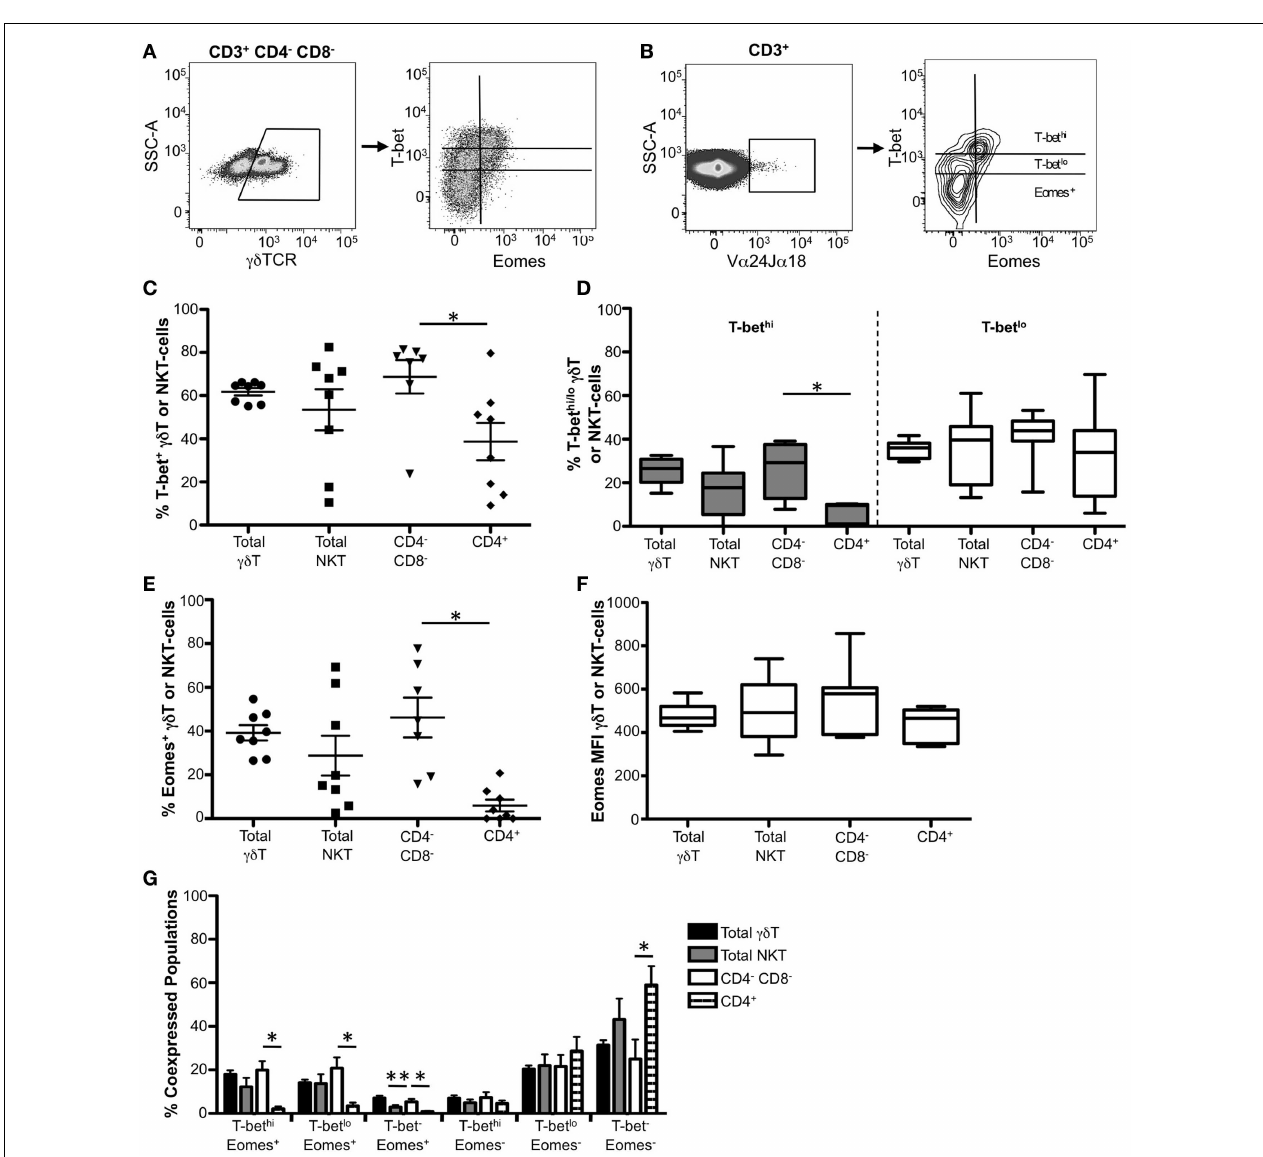
donor. (D) Graphical representation of the mean frequency ofT-bet hi (gray) and T-bet lo (white) expression in these populations is shown.The box and whisker graphs display 25–75% (box), 10–90% (whisker), and the median value (line). (E) The frequency of Eomes + γδ and iNKT cells is shown for each cell subset. (F) Median fluorescence intensity (MFI) is shown for Eomes + cells within each cell subset. (G) The frequency ofT-bet and Eomes co-expression within each cell population is shown. * p <